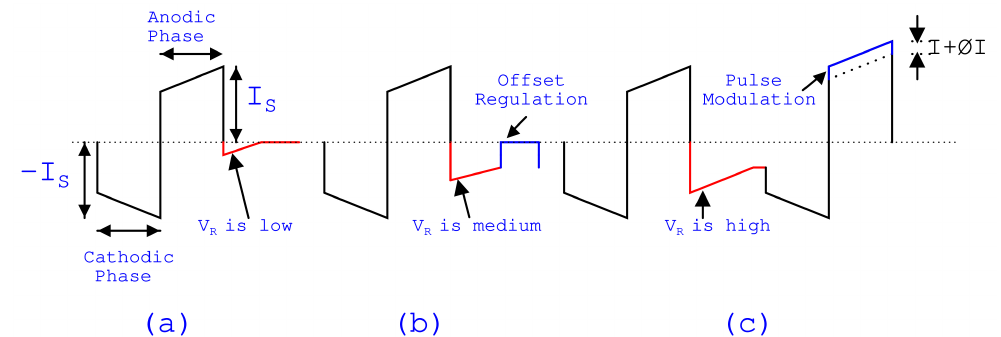
Figure 6. ( a ) When residual voltage is low, ( b ) when residual voltage is medium, and ( c ) when residual voltage is high.